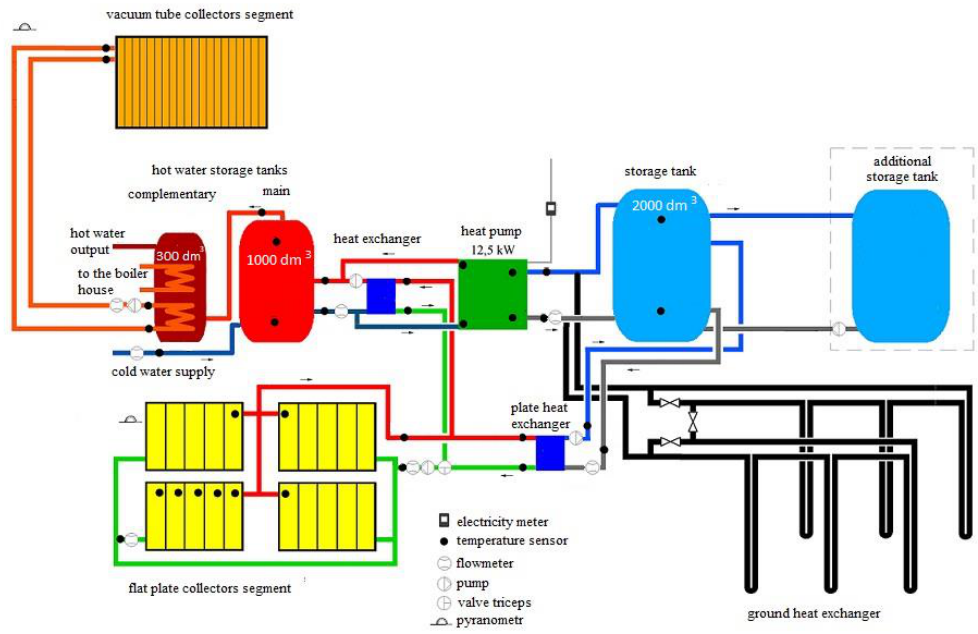
Figure 1. Hybrid energy system. Reproduced with permission from [6], Copyright Elsevier, 2018.